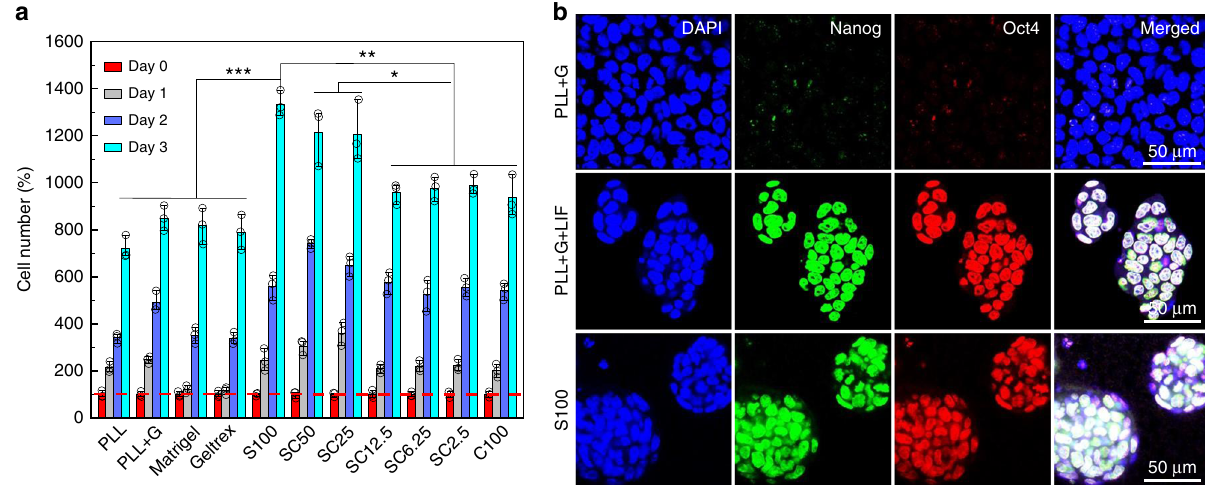
Fig. 6 Stem cell cultivation and maintenance of mESC stemness. a Quanti fi cation of time-dependent mESC growth on various substrata, normalized to data obtained from mESC on PLL for 4 h (red dashed line). All data are represented by mean ± S.D. of triplicate samples. b Representative fl uorescence images of immunostained mESCs grown for 4 days on gelatine-coated PLL in the absence (upper row) or presence (middle) of LIF or on S100 in the absence of LIF (bottom).